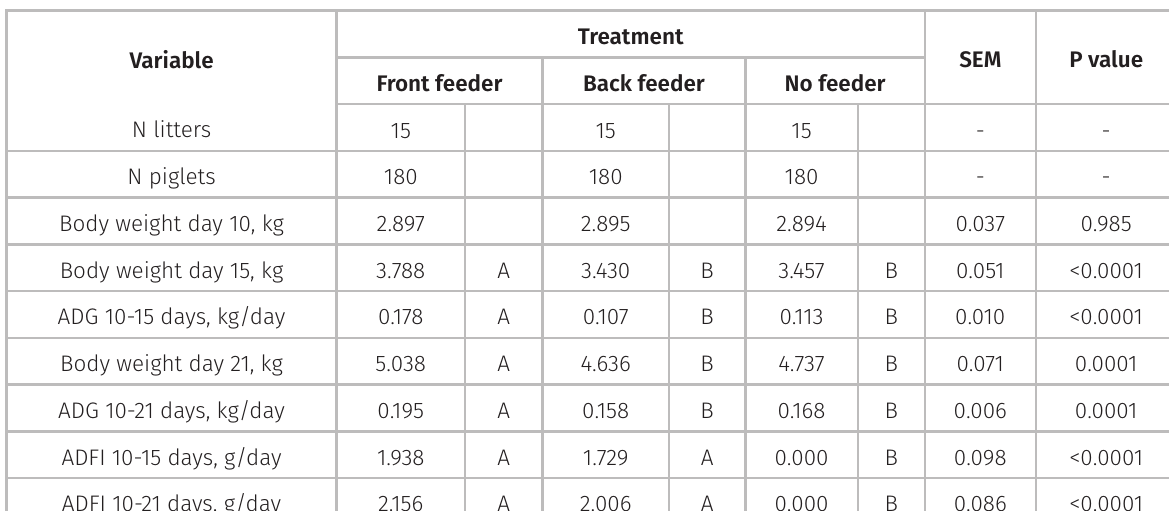
Table I. Performance of piglets from 10 to 21 days after farrowing with different positions of piglet feeder on the farrowing crate or without piglet